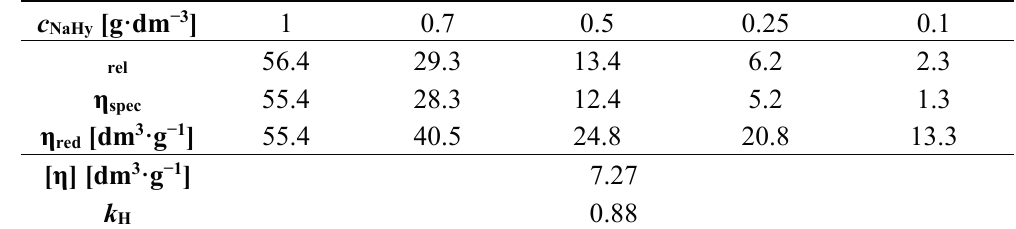
Table 1. Values of relative, specific, reduced viscosity, LVN and Huggins parameter.